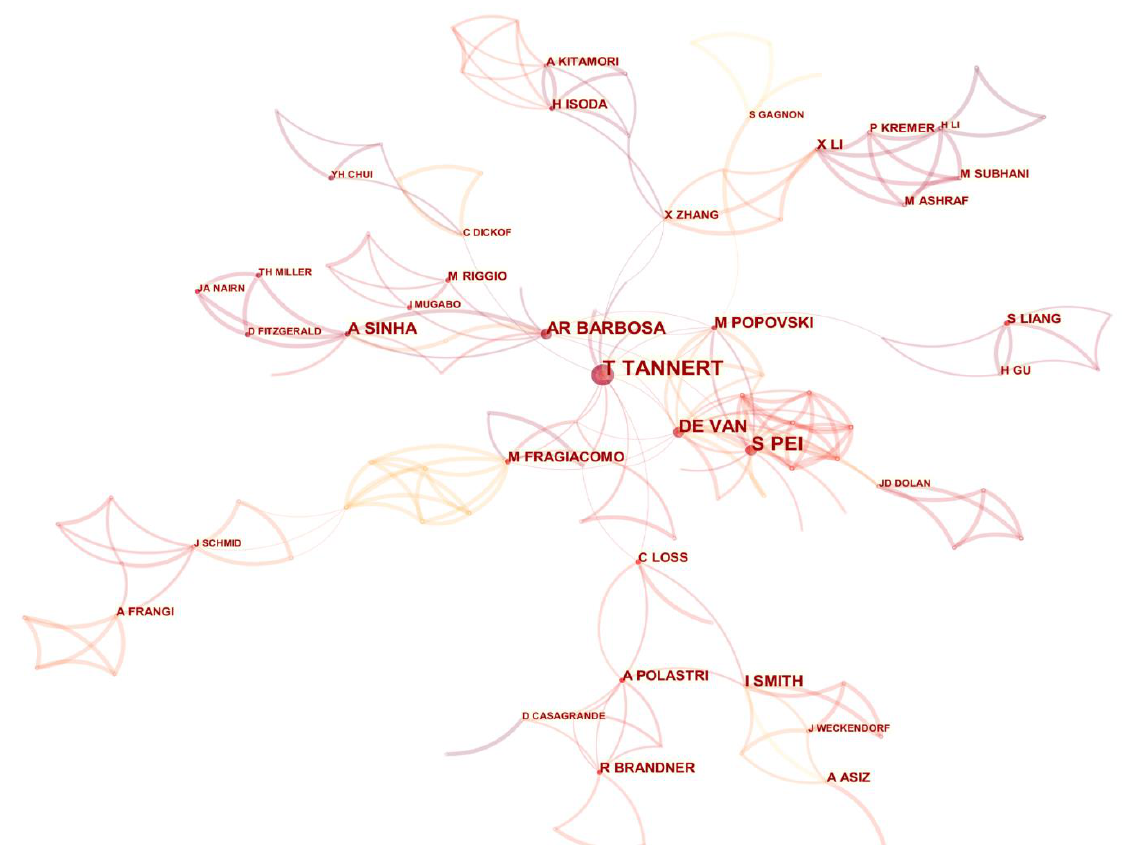
Figure 5. Co-authorship network map for academic articles for cross-laminated timber in construction. Table 4. General parameters of the co-authorship network. Network Nodes Links